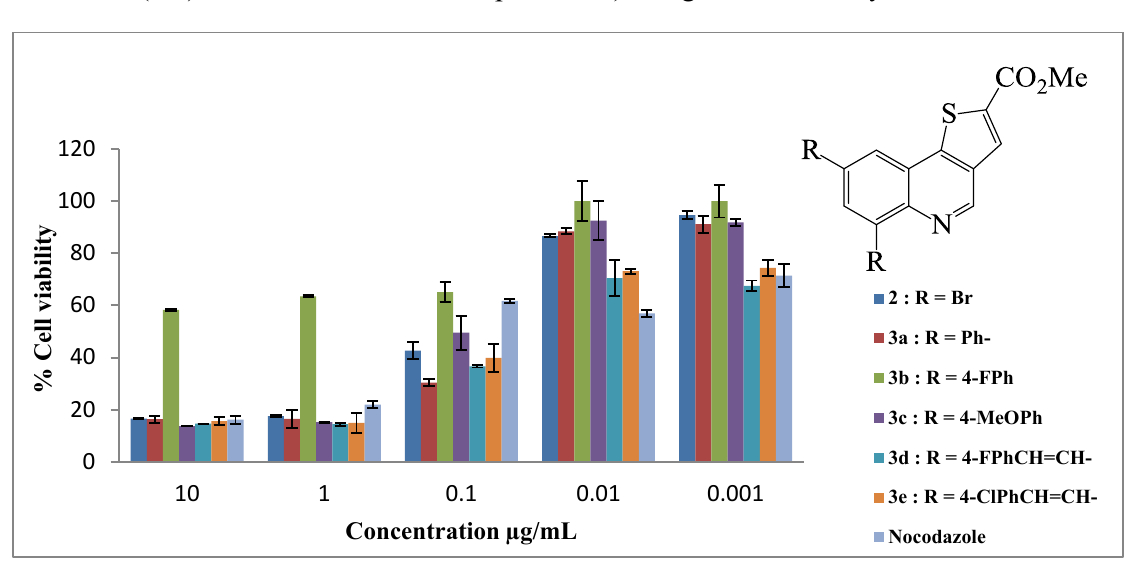
Figure 1. In vitro antiproliferative activities of thienoquinolines 2 and 3a – e on human breast cancer cell line MCF-7. Results are presented as percentage cell viability (±standard deviation (SD) from three individual experiments) using the MTT